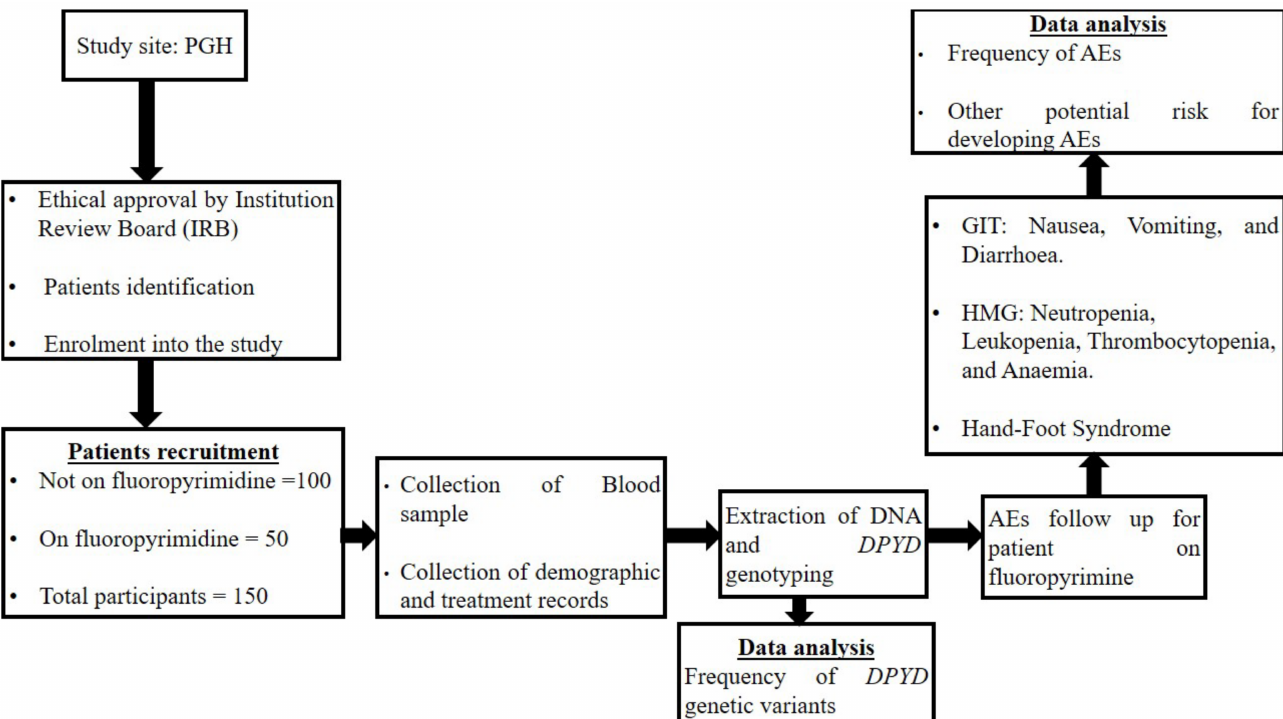
Figure 1. Flow diagram illustrating the visual representation of the methodology (AEs., adverse events; DPYD. , dihydropyrimidine dehydrogenase; GIT., gastrointestinal; HMG., haematological; P.G.H., Parirenyatwa Group of